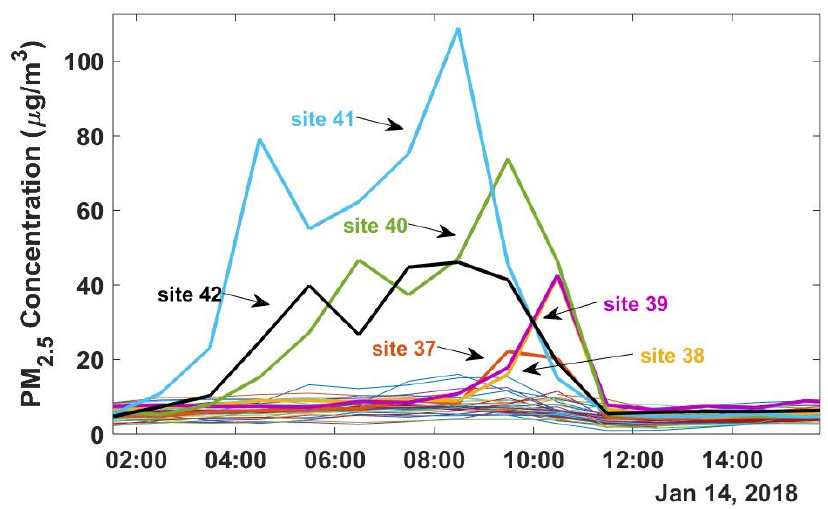
Figure 2. Example of a high PM 2.5 event associated with local emissions. This figure is exemplary of periods of time throughout the study period when sites surrounding the Coke plant (indicated by thick lines) experienced elevated PM 2.5 concentrations due to plant emissions while all other sites (thin lines) maintained background PM 2.5 concentrations.